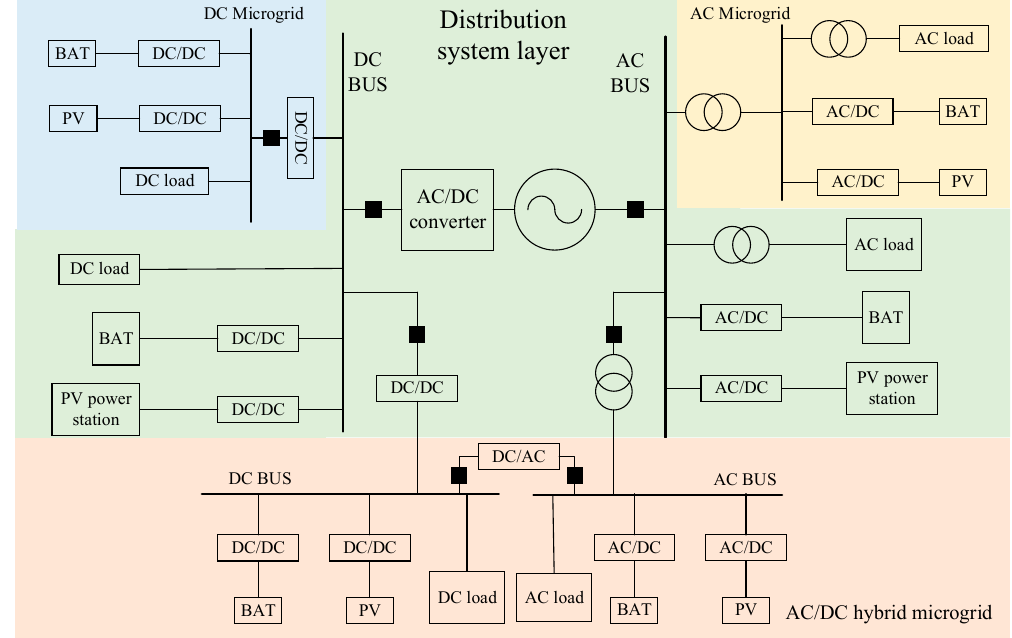
Figure 1. Typical structure of alternating current/direct current (AC/DC) hybrid microgrid connected to AC/DC distribution network.